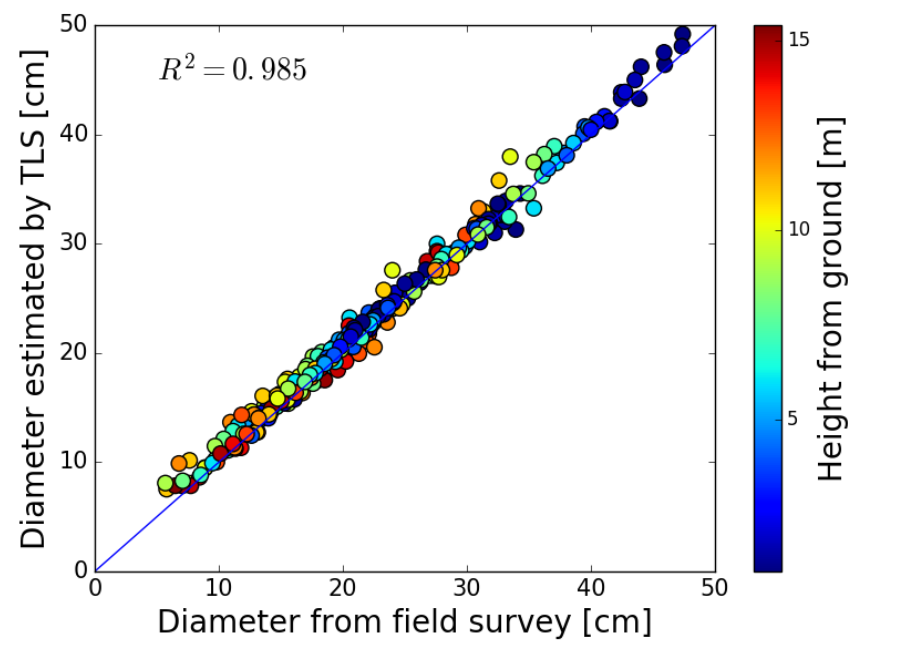
Figure 16. Scatter plot of the stem diameters estimated by TLS versus the stem diameters measured in the field survey for all of the trees in Plots 1–6. The identity line is blue. For stem profile diameters RMSE, bias and omission errors, see Table 7. The parameter settings used in the stem profile detection method were: voxel size of 3 cm, curvature weight of 0.75 and cluster weight of